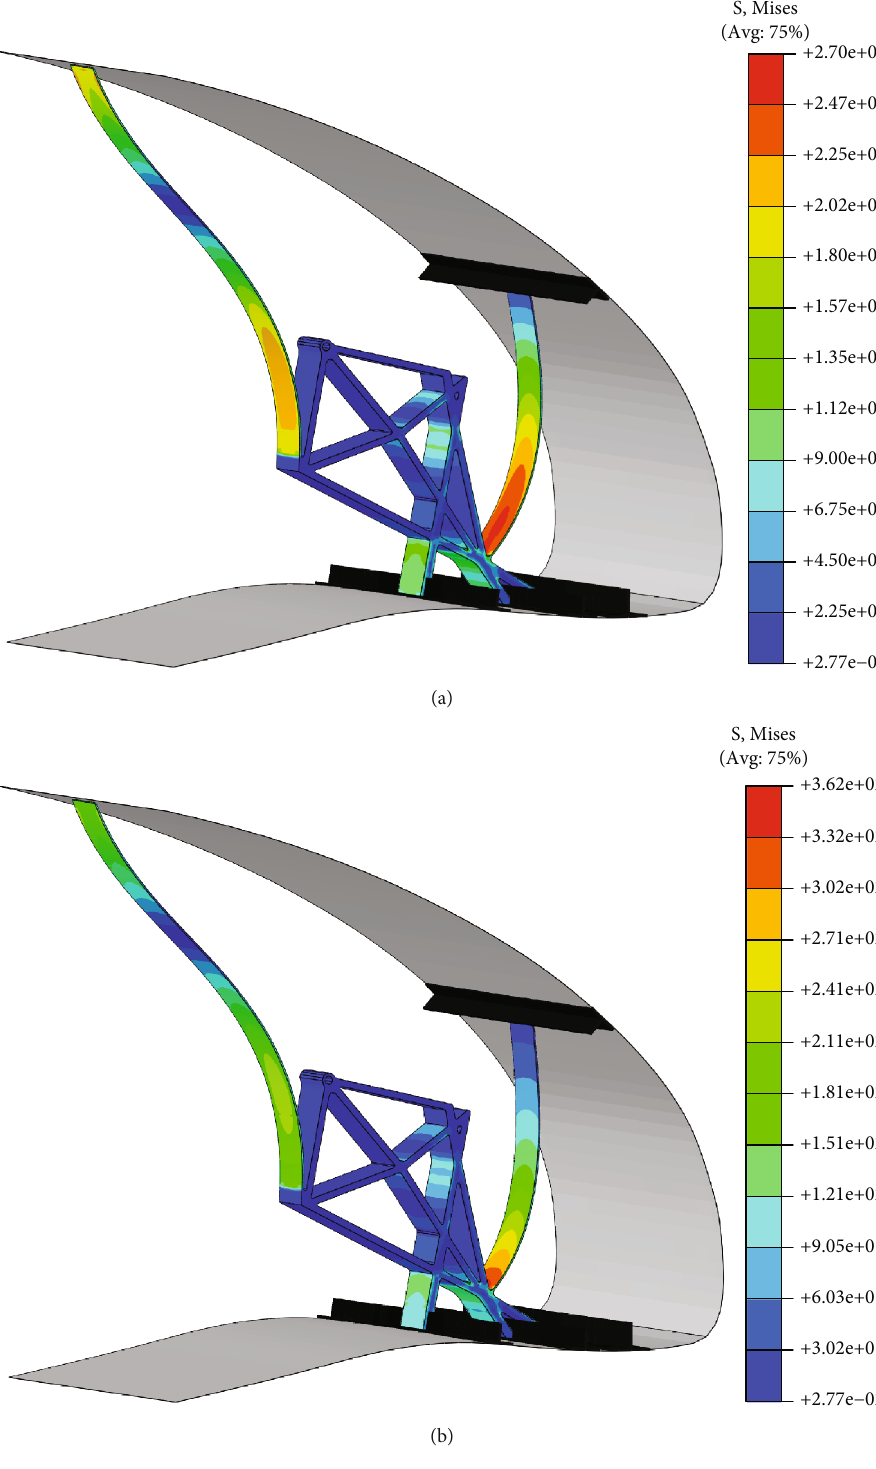
Figure 12: Stress in the root rib. (a) Limit loads. (b) Ultimate